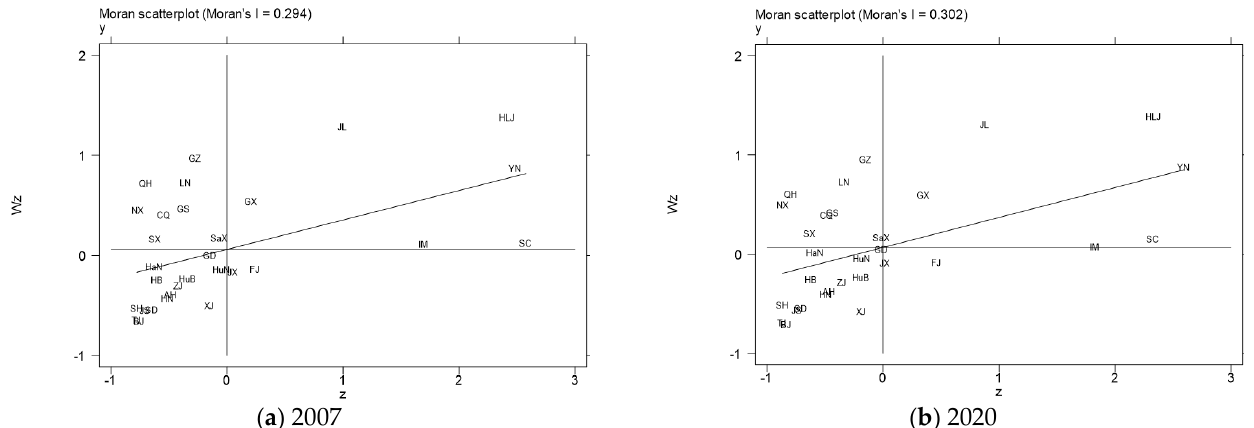
Figure 1. The local Moran scatter plots of forest carbon sinks in China in 2007 ( a ) and 2020 ( b ).